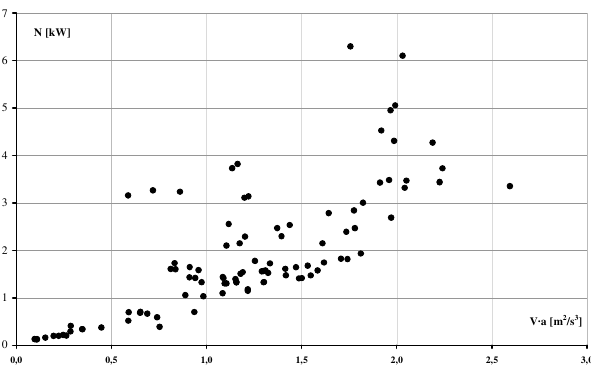
Fig. 10. The average power of movement resistance as a function of the product of the average speed and the average car delay